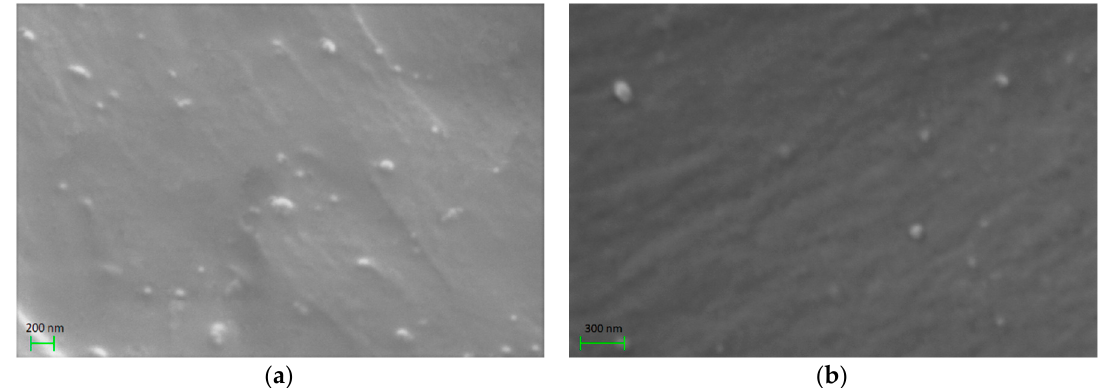
Figure 1. Scanning electron microscopy (SEM) images for the nanocomposites with 5 phr: ( a ) BaFe 12 O 19 ; ( b ) SrFe 12 O 19 content.